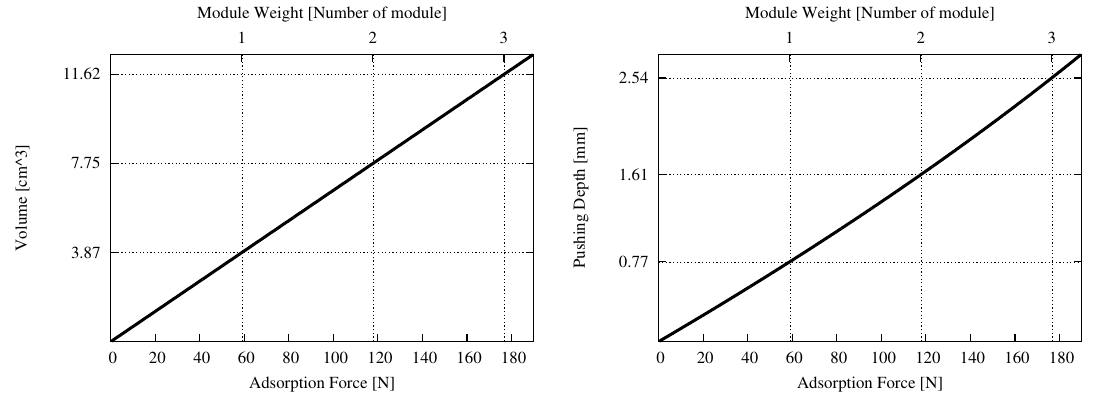
Figure 12. ( Left ): Therequiredvolumevariationcorrespondingtotheadsorptionforce; ( Right ):Thevariation of the required pushing depth corresponding to adsorption